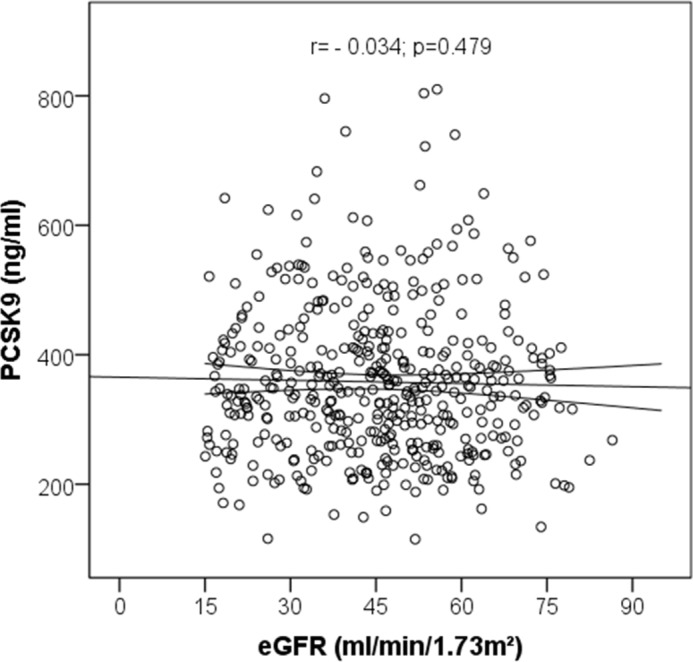
Correlation between PCSK9 and estimated glomerular filtration rate (GFR) assessed by Spearman test.